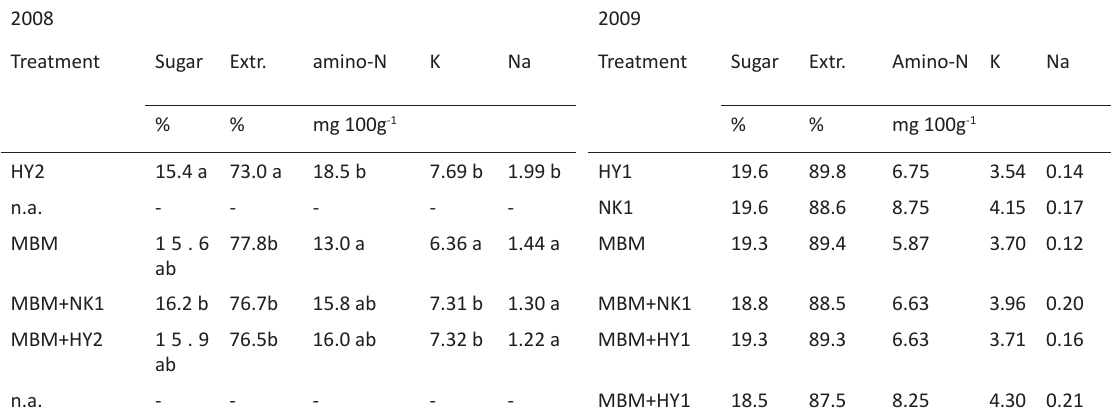
Table 9. Sugar content, extractability, amino-N, K and Na concentrations in sugar beet in 2008 and 2009 2008 2009